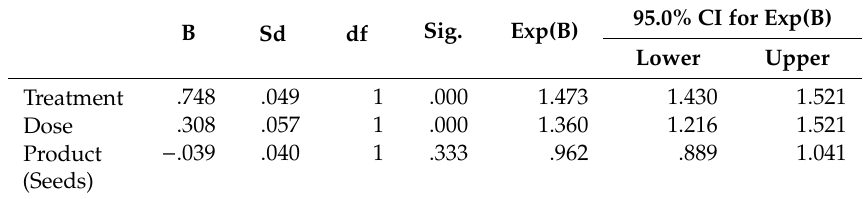
Table 7. Variables in the Equation from Cox regression ( Chi–square : 301.764, df = 3, p < 0.001). 95.0% CI for Exp(B) B Sd df Sig. Exp(B) Lower Upper Treatment .748 .049 1 .000 1.473 1.430 1.521 Dose .308 .057 1 .000 1.360 1.216 1.521 − .039 .040 1 .333 .962 .889 Product (Seeds)